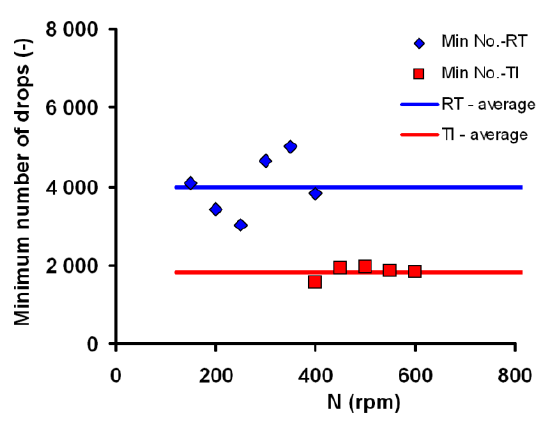
Fig. 5. Minimum number of drops for evaluation – effect of impeller rotational speed.